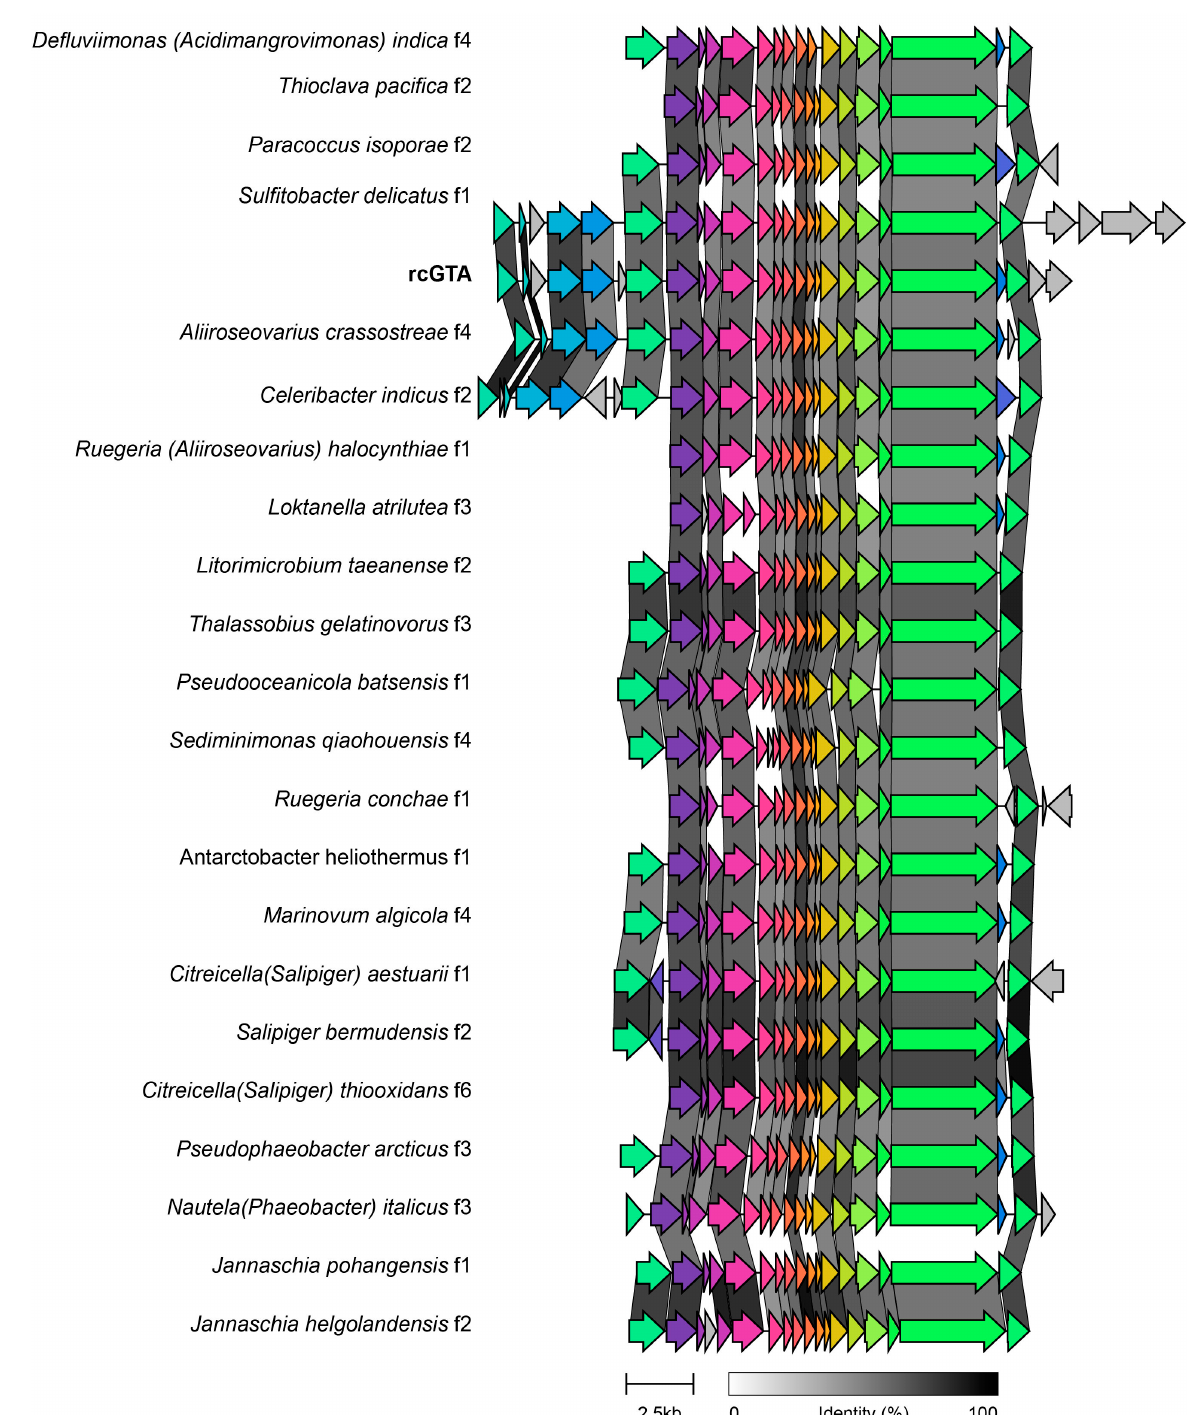
Figure 4. Genome alignments between the Rhodobacter capsulatus strain 1003 gene transfer agent (rcGTA, indicated in bold) and the 22 putative prophages encoding cysE . The grey bars indicate the percent identity of the amino acid alignments between shared genes. The letter f following the host name indicates genome fragment, which replaces “prophage” in this analysis.